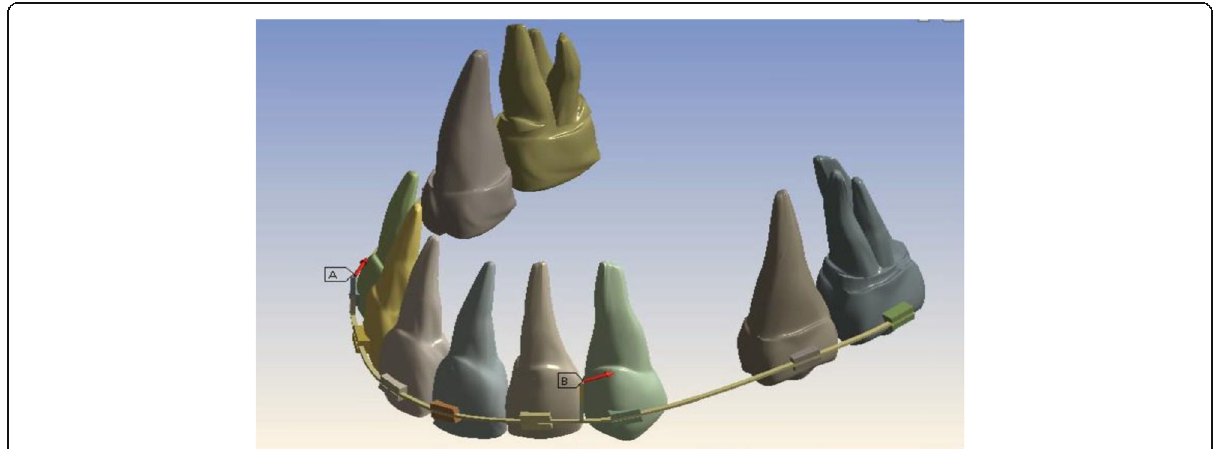
Fig. 2 Geometric models of the teeth, wire, bracket, and hook